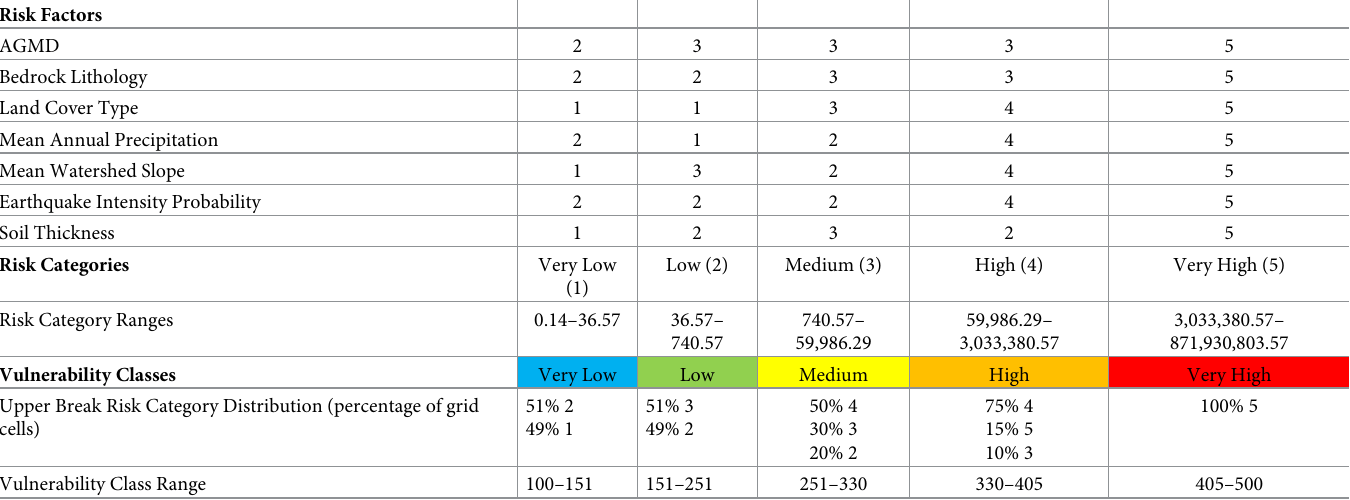
Table 2. Risk Factor (RF) distribution in Risk Categories for the tropical Erosion Vulnerability Index (EVI) and Vulnerability Classes for watershed EVI and Ero- sion and Deposition Index (EDVI). These categories are also used for the EVI-STJ and EDVI-STJ. Table modified from Browning and Sawyer, 2021 [47].